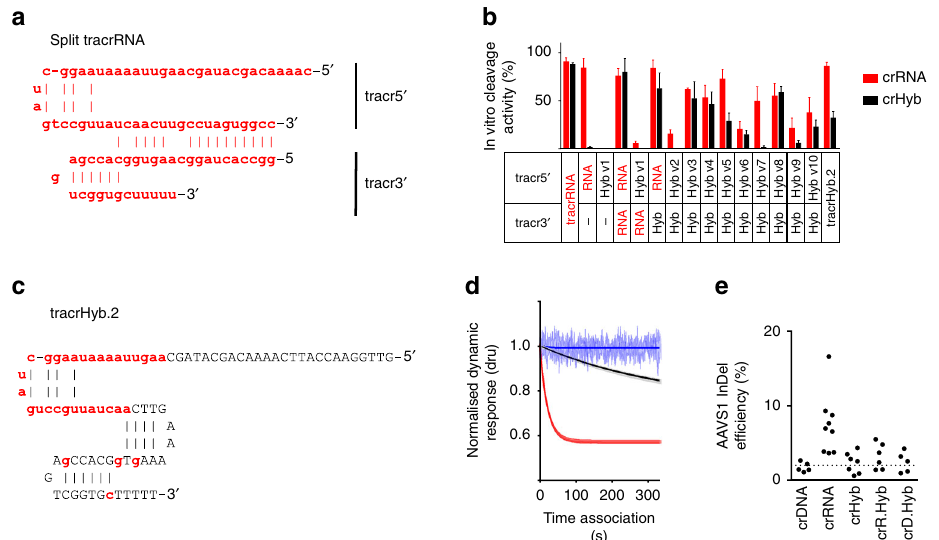
Fig. 6 Biochemical and cellular characterisation of tracrHyb. a Design of the split-tracrRNA molecule. b Quanti fi cation of in vitro cleavage of target DNA by Cas9 complexes with crRNA (red) or crHyb (black) and combinations of single or split tracr molecules. c Design of the single tracr hybrid molecule (tracrHyb.2). d SwitchSENSE traces showing association phase of Cas9:tracrHyb.2:crXNA complexes binding to target DNA, coloured as in 3b. e Quanti fi cation of InDel events at the AAVS1 locus 5 days after electroporation of complexes composed of Cas9 and crRNA (red), crR.Hyb (green) or crDNA (black), and tracrRNA or tracrHyb.2. Dotted line shows threshold determined from crDNA samples and. For all charts, bars show mean + SD, n >